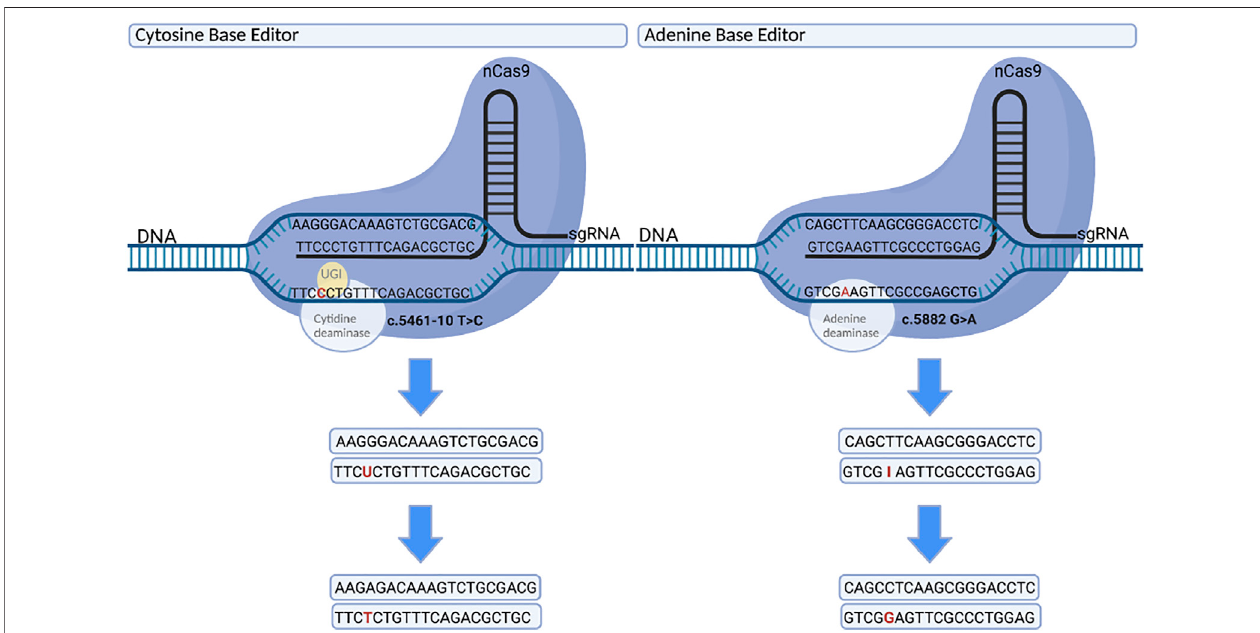
FIGURE 1 | Cytosine base editor (left) and adenine base editor (right) showing respective single base corrections of common ABCA4 mutations, c.5461-10T > C and c.5882G > A. Cas9 complexes with a guide, interrogates the genome for the matching sequence, and binds. The opposite strand is freed, allowing the deaminase domaintoactonthetargetbase.ThismediatesC > TandA > Gchanges,enablingcorrectionofallfourtransitionmutations:G > A,A > G,C > T,andT > C.Createdwith BioRender.com.